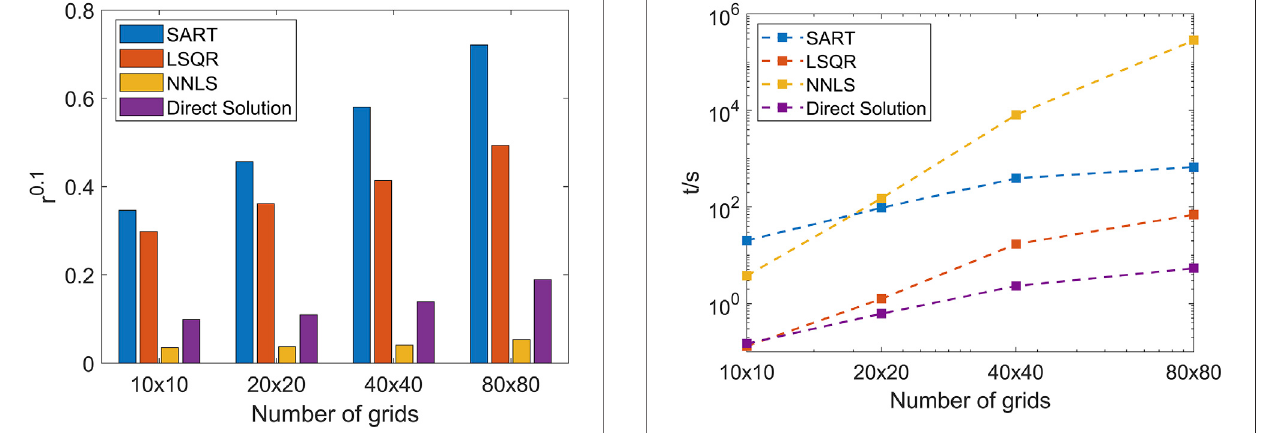
FIGURE 9 | The in fl uence of the grids number on the overall reconstruction error.